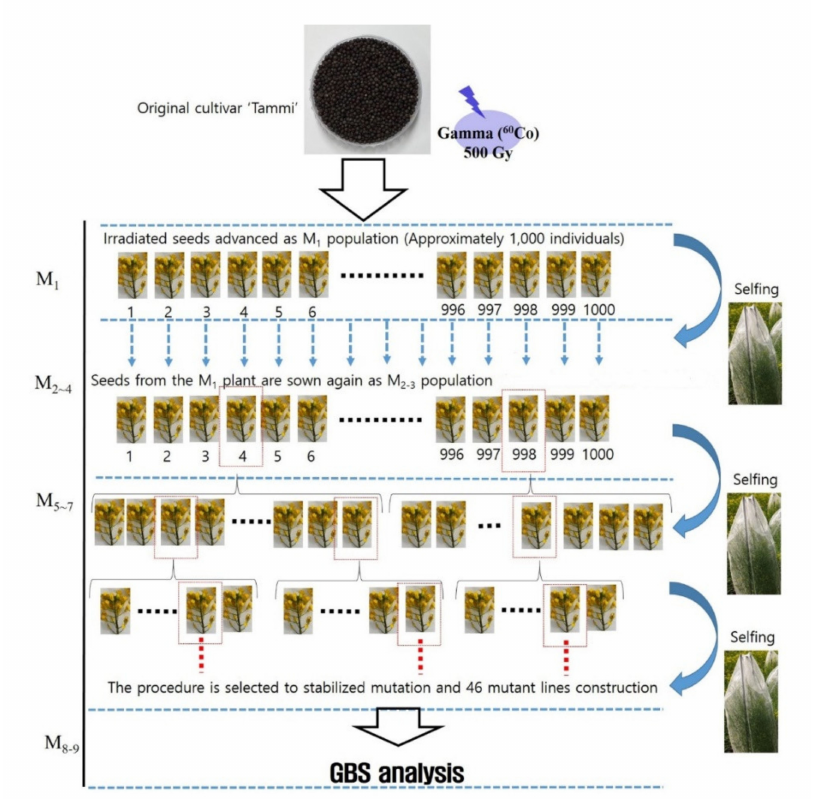
Figure 1. The development of mutant lines. The 46 mutant lines were identified from the M 2 to the M 4 population that flowering times, crude fat and fatty acid composition and was derived from the Korean rapeseed cultivar ‘Tammi’ with 500 Gy gamma ray irradiation. This mutant line was homozygous from the M 5 to the M 8-9 generations. At each generation, phenotypes, crude fat, and fatty acid compositions were